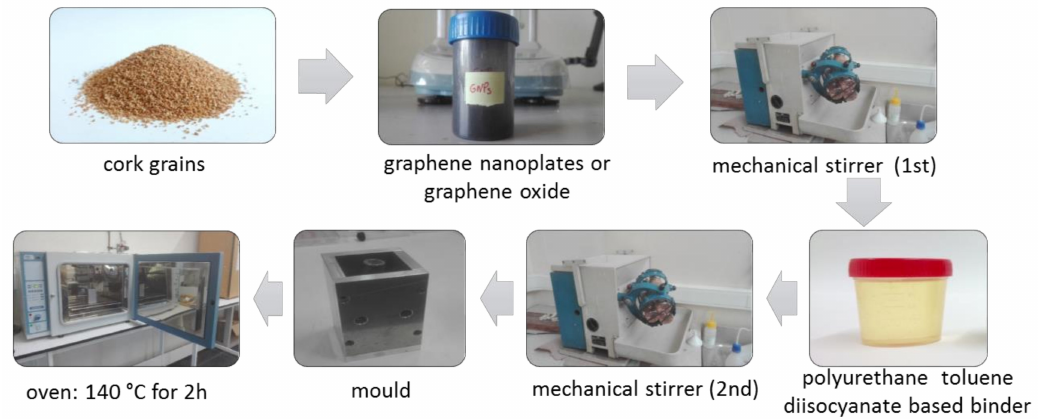
Figure 1. The cork-graphene samples production.